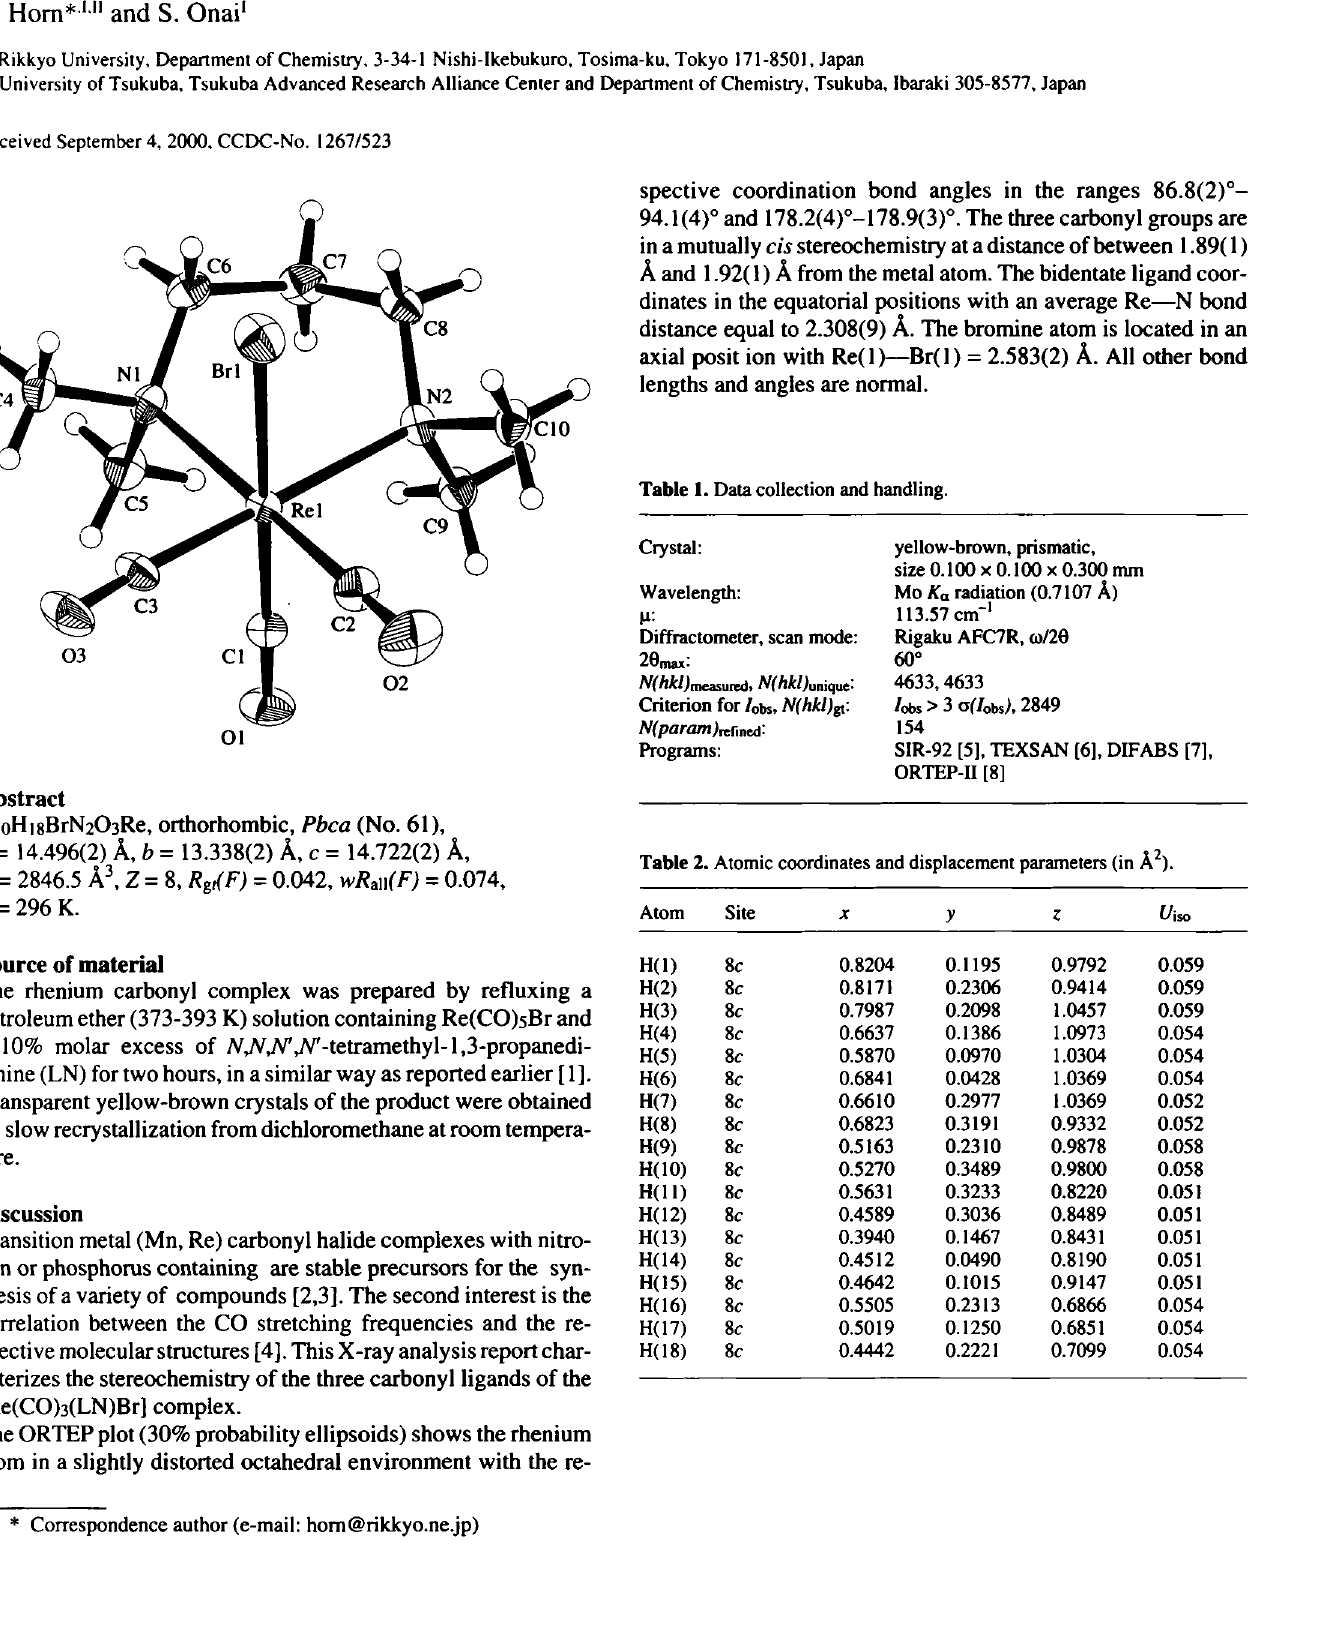
Table 1. Data collection and handling.